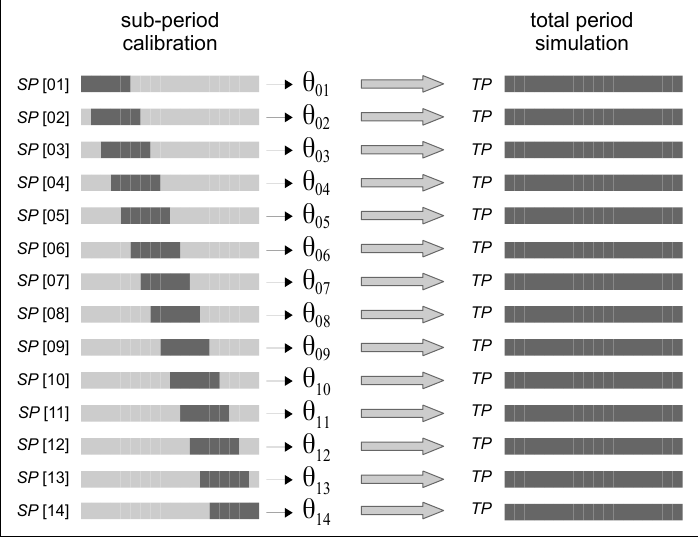
Fig. 3. Sub-period (SP) calibration procedure and simulation over the total period (TP) (example of 5yr sub-periods within an 18yr total